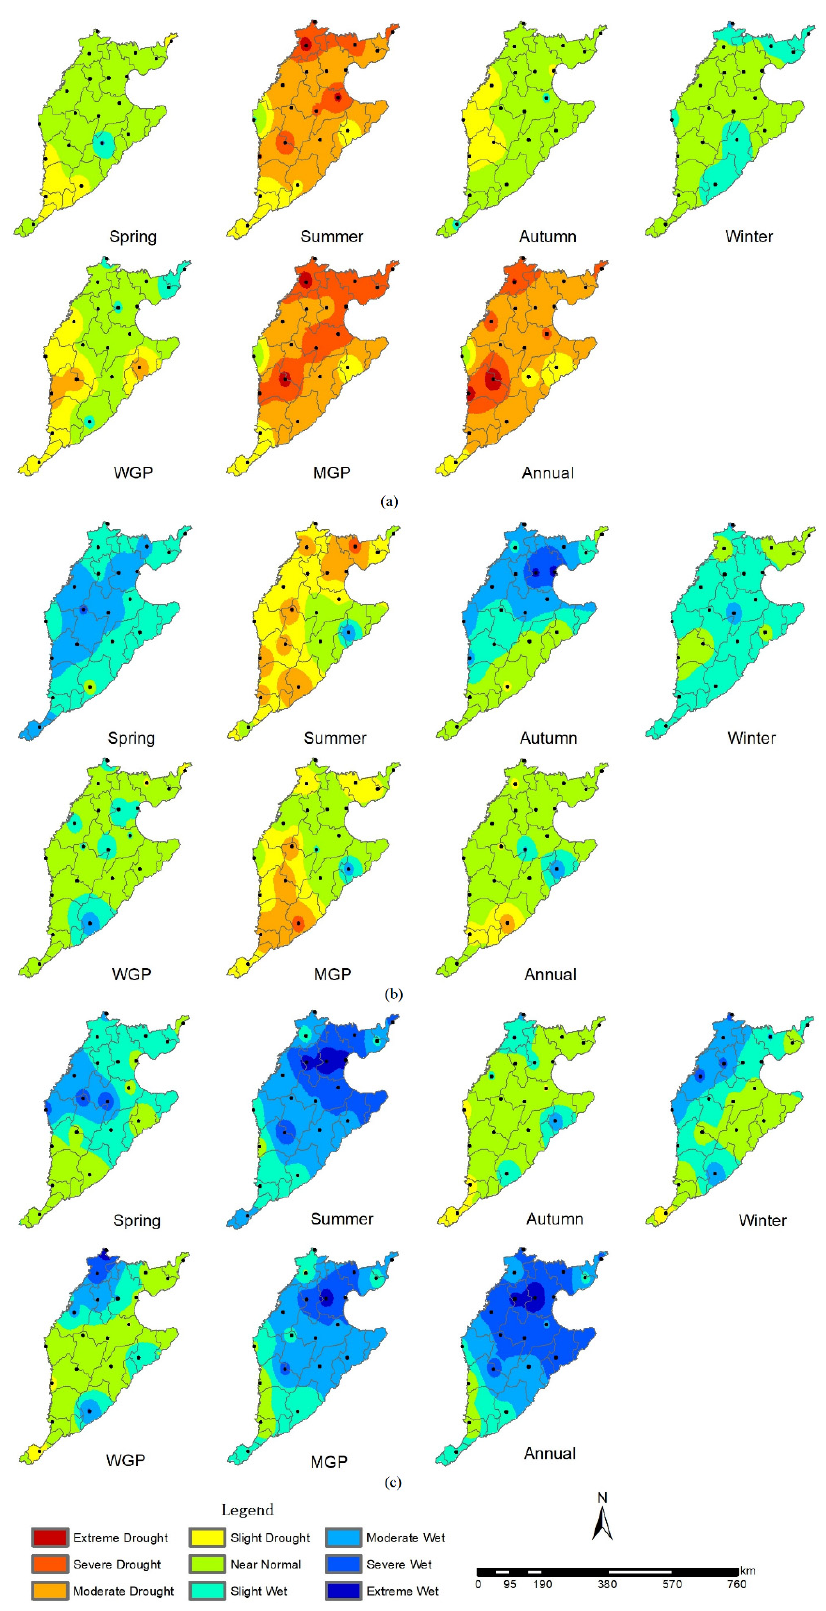
Figure 6. Spatial distribution of the SPI at different timescales in typical years. ( a ) 1999—dry year,